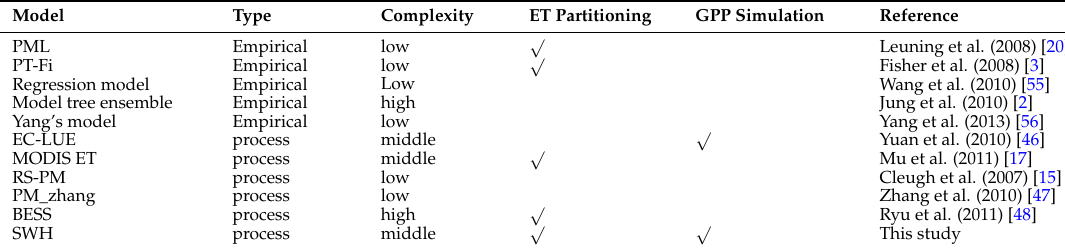
Table 4. List of ET models driven by remote sensing and climate data. Note that the models estimating ET indirectly with the energy balance approach are not included. PML: Penman—Monteith—Leuning, PT-Fi: Priestley—Taylor—Fisher. RS-PM: Remote Sensing Penman—Monteith. BESSS: Breathing Earth System